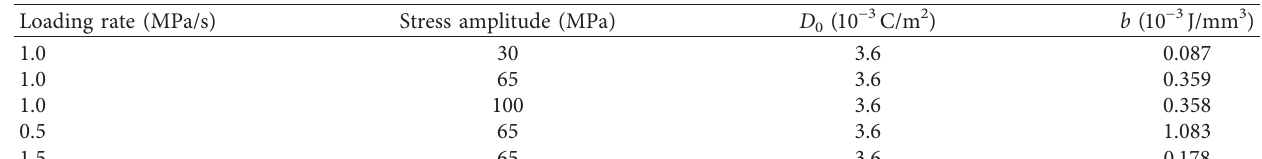
Table 3: The parameters of D